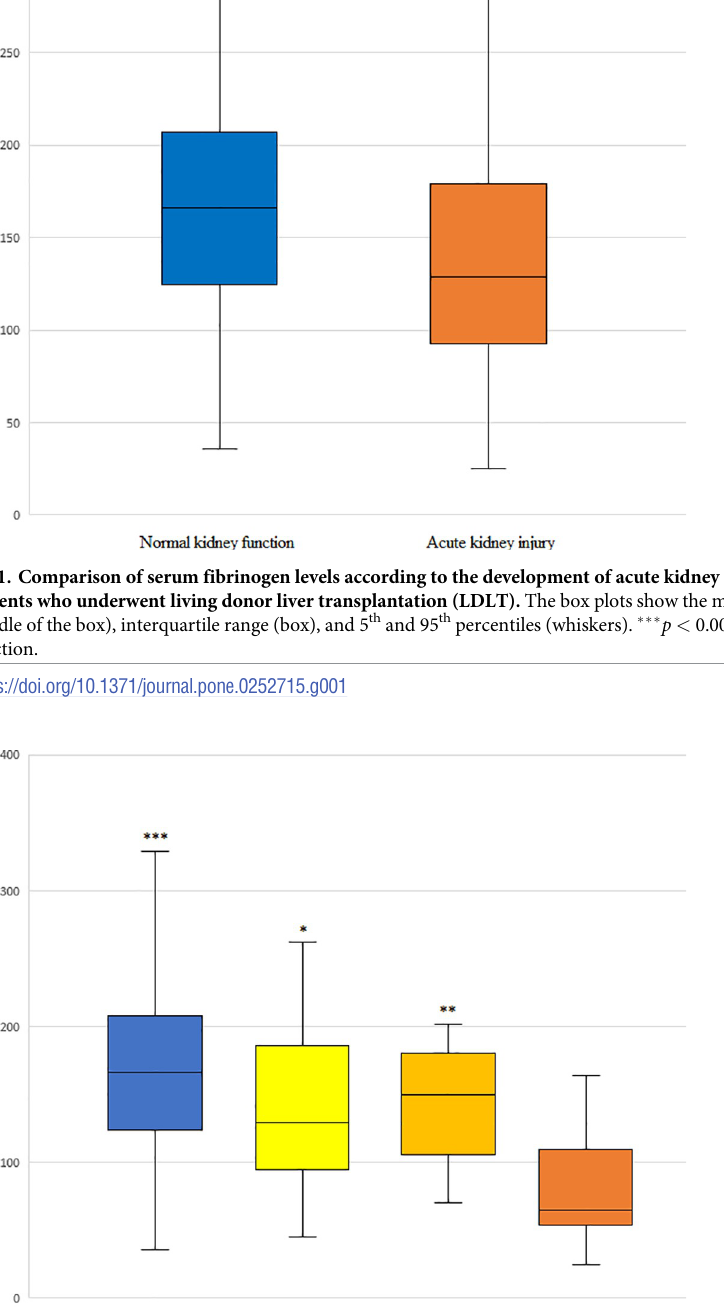
PLOS ONE | https://doi.org/10.1371/journal.pone.0252715 June 4,